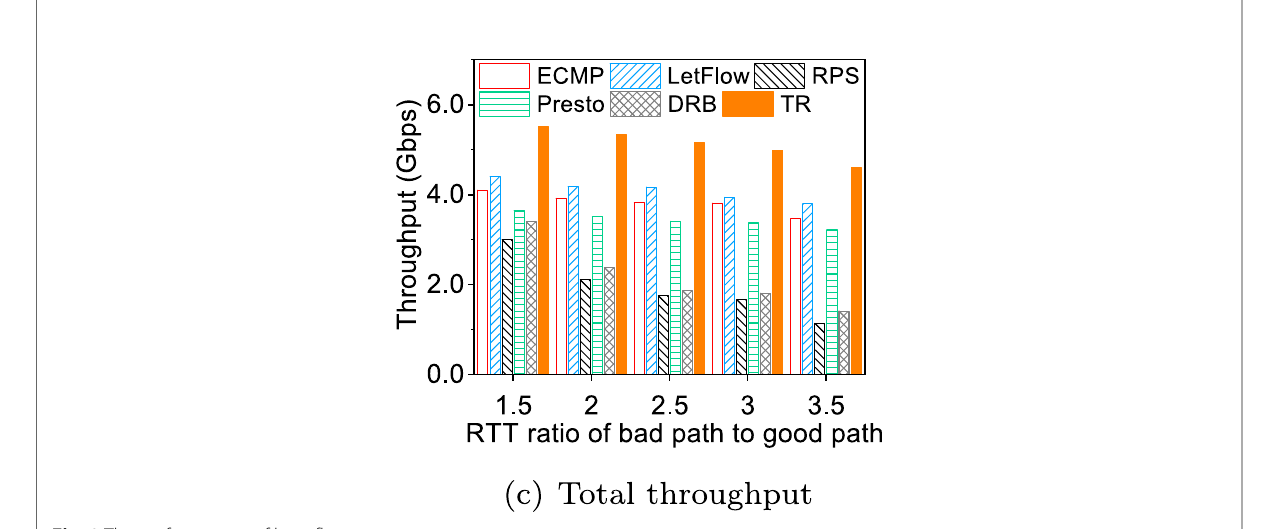
Fig. 8 The performances of long flows